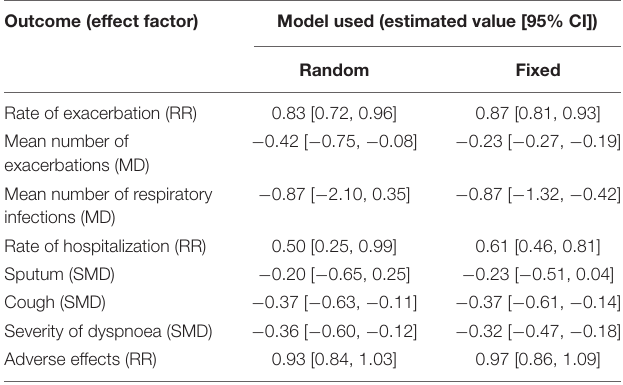
TABLE 4 | Results of the meta-analysis by the alternative